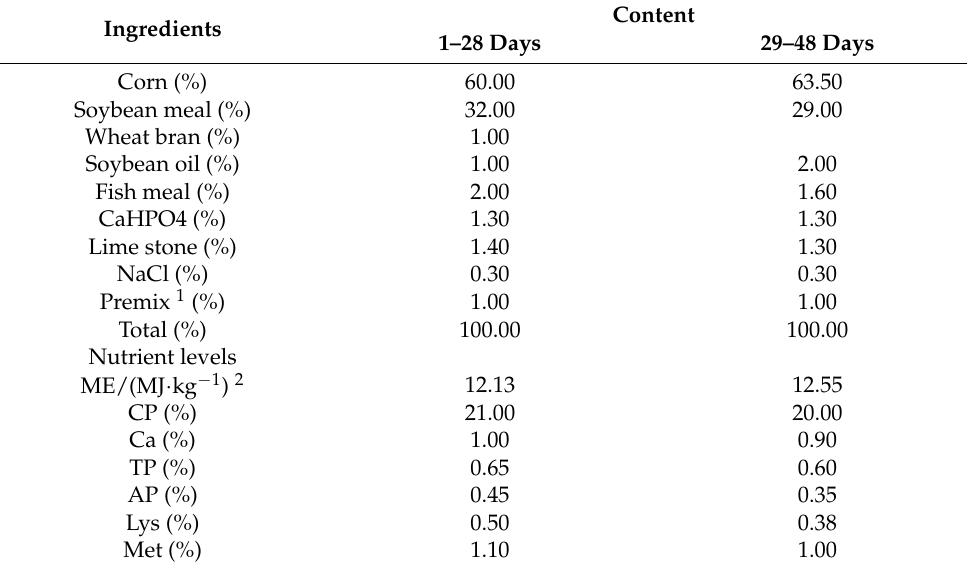
Table 1. Composition and nutrition level of basic